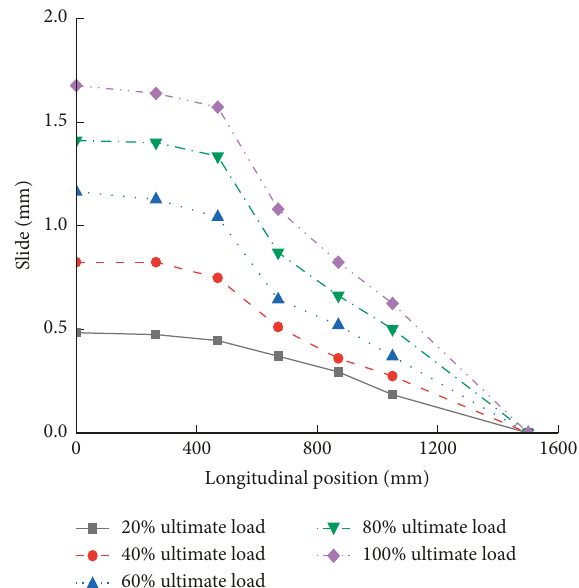
Figure 13: Sliding displacement between the Steel plate and UHPC